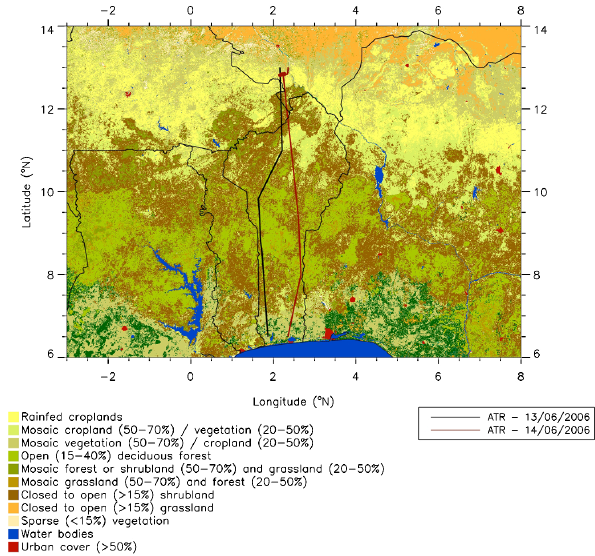
Fig. 1. GlobCover Land Cover map, with the flight plans of the ATR-42 on 13 and 14 June 2006. The map is derived from a time series of MERIS FR mosaics using the UN land Cover Classifi- cation System (Source data: ESA/ESA Globcover project, led by